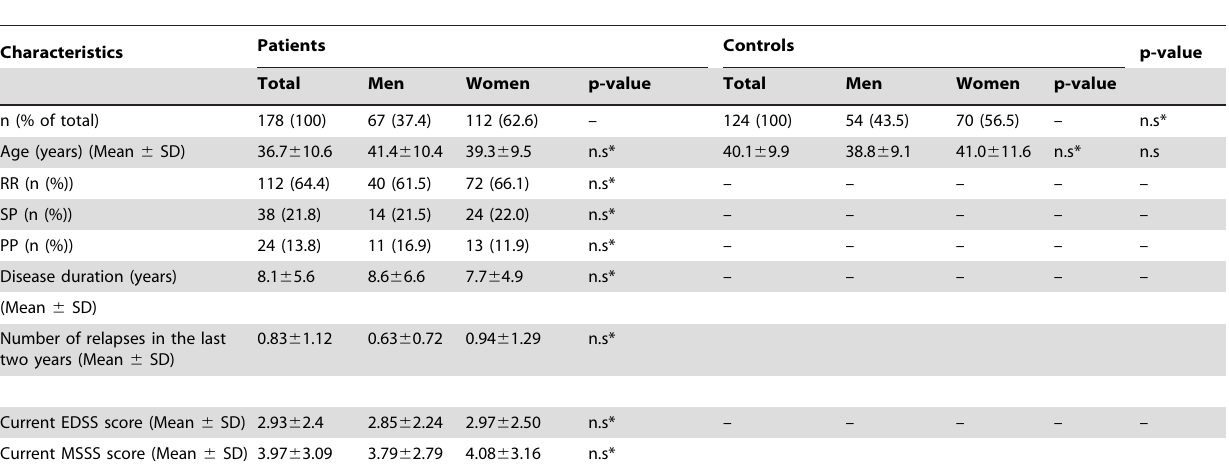
Table 1. Clinical and demographic characteristics of MS patients and controls, stratified by sex.